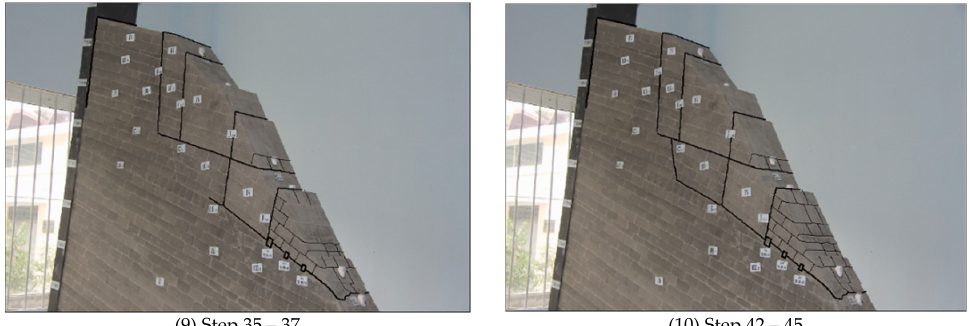
Figure 11. Failure pattern of the full process.